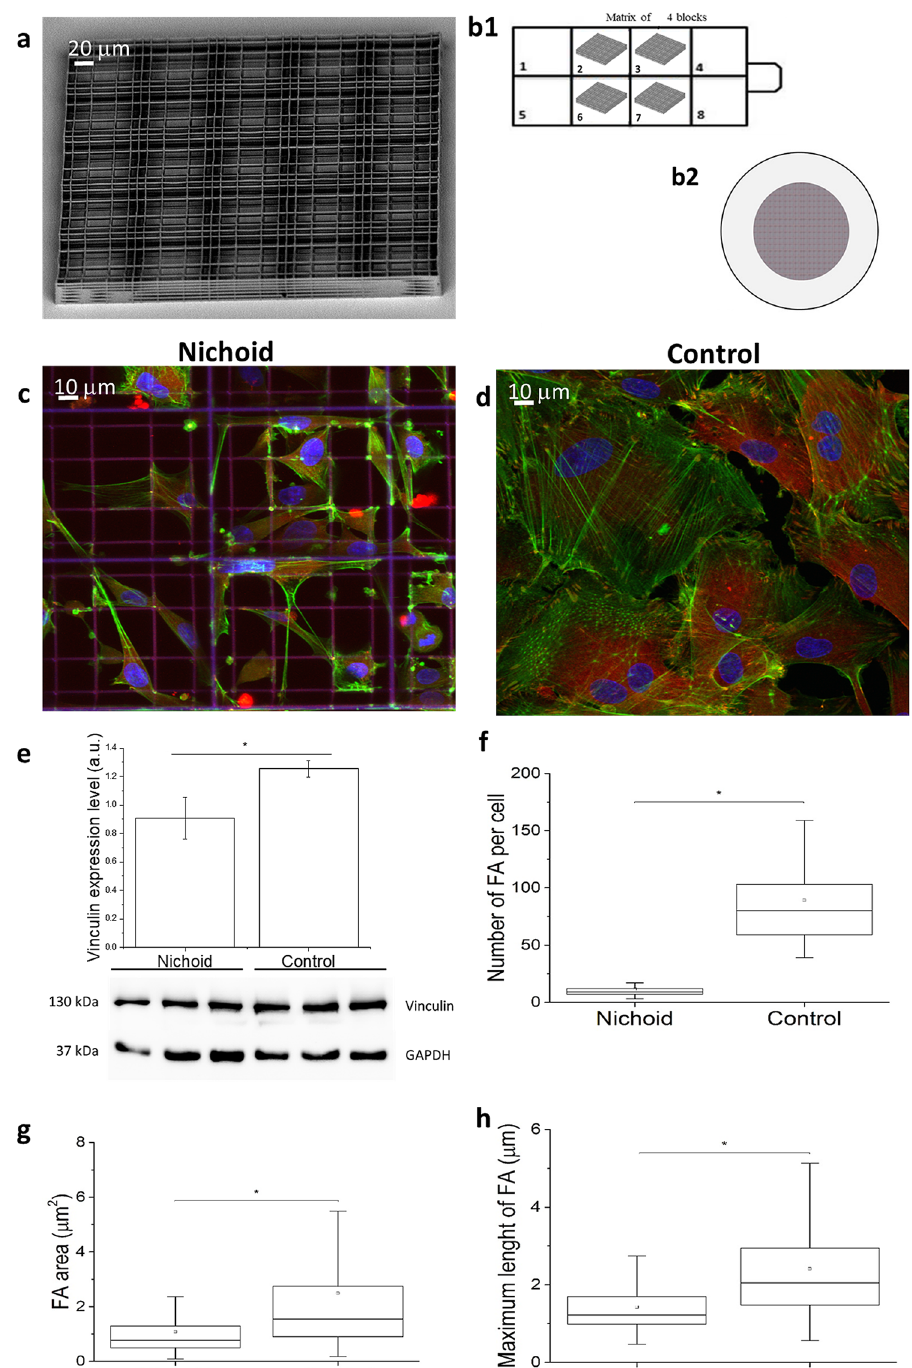
Figure 1. Spatial organization of focal adhesions in MSC adhering to the Nichoid artificial niche. ( a, b ) SEM images of the Nichoid microstructured module cell scaffold and schematic representation of the samples produced ( b ): b1 glass bottom Nunc Lab-Tek-8-chamber wells and ( b2 ) 1.2 cm diameter glass culture coverslip. The software used to create the image b1 and b2 are Microsoft PowerPoint 2018 (https ://produ cts.offic e.com/ it-it/power point ) and SolidWorks Education Edition 2020 (https ://www.solid works .it/sw/educa tion/mecha nical -engin eerin g-stude nt-softw are.htm). ( c, d ) Immunostaining of nuclei (blue), actin (green) and vinculin (red) in cell grown into the Nichoid ( c ) and on glass flat substrate ( d ). ( e ) Vinculin expression level calculated by western blot technique: actin production is reduced in cells grown into the Nichoid. ( f ) Number of focal adhesions per cell. Spread cells present a high number of traction forces sites respect to the cells grown into the Nichoid. ( g ) Focal adhesion area. The Control shows the presence of big focal adhesions respect to the cell into the Nichoid. ( h ) Focal adhesions length. The Control presents a big number of mature focal adhesions (2 µm < length < 20 µm). Graphs statistics: Mann–Whitney test. * Correspond to p <